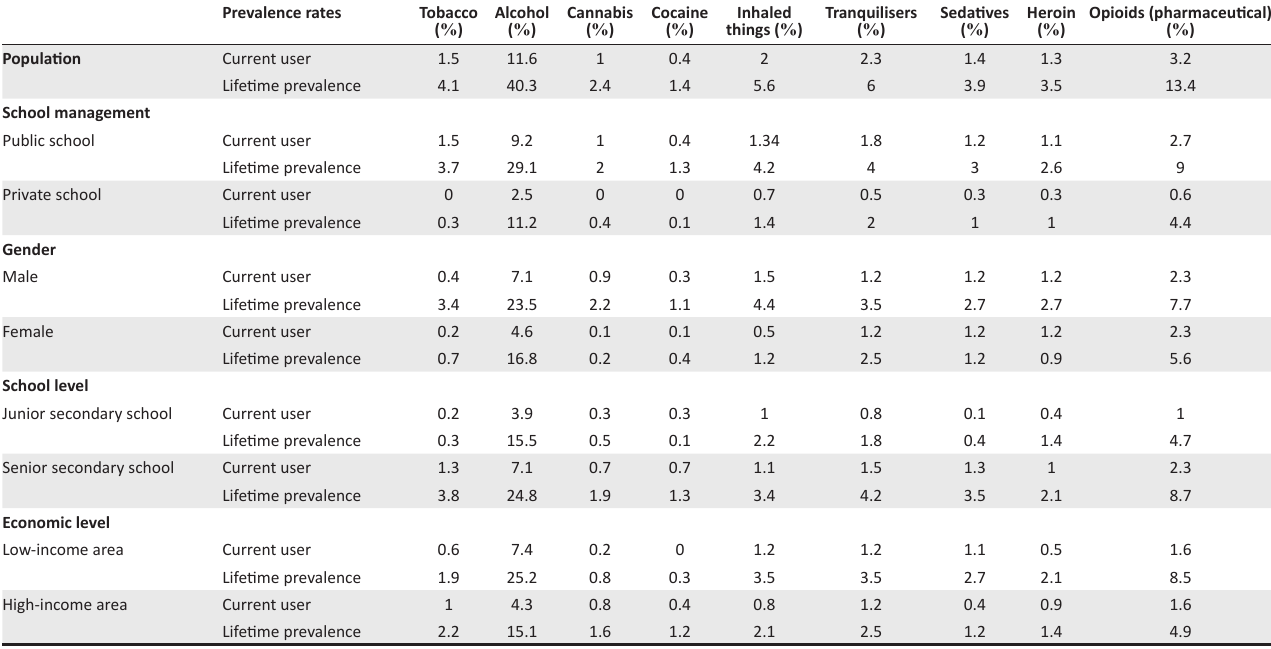
TABLE 2: Drug use prevalence ( % ) amongst secondary school students in Lagos State, Nigeria ( n = 1048). Prevalence rates